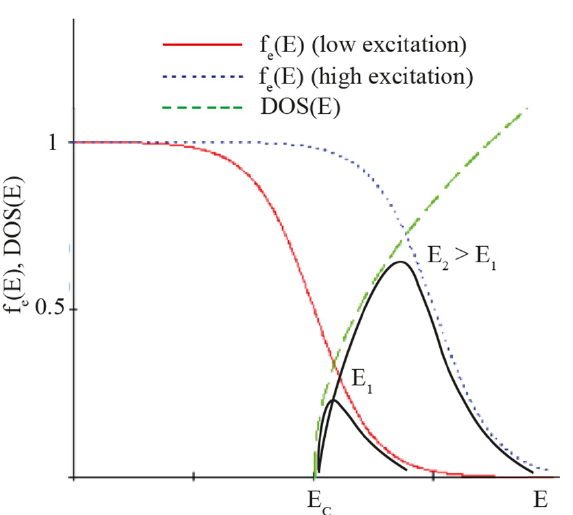
Figure 5. DOS and electron Fermi–Dirac functions for different excitation powers and their overlap (black curve) in both cases. (black curve) in both